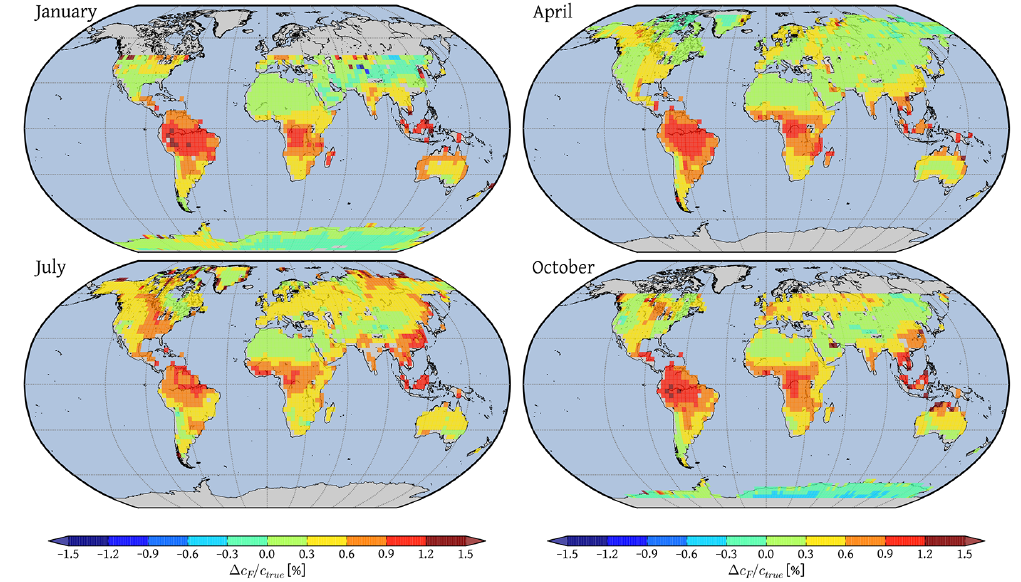
Figure 7. XCH 4 retrieval error (cid:49)c F /c true [ % ] for retrieval concept SW1+3 (both SWIR1 and SWIR3 bands).